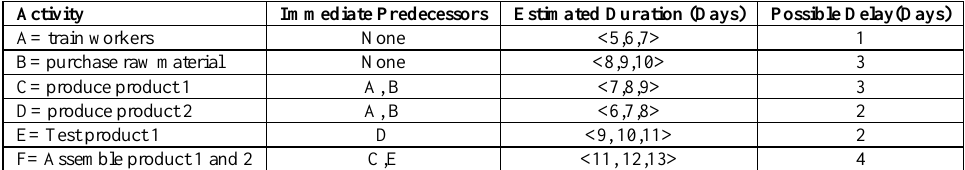
Table 1. Time duration for the activities